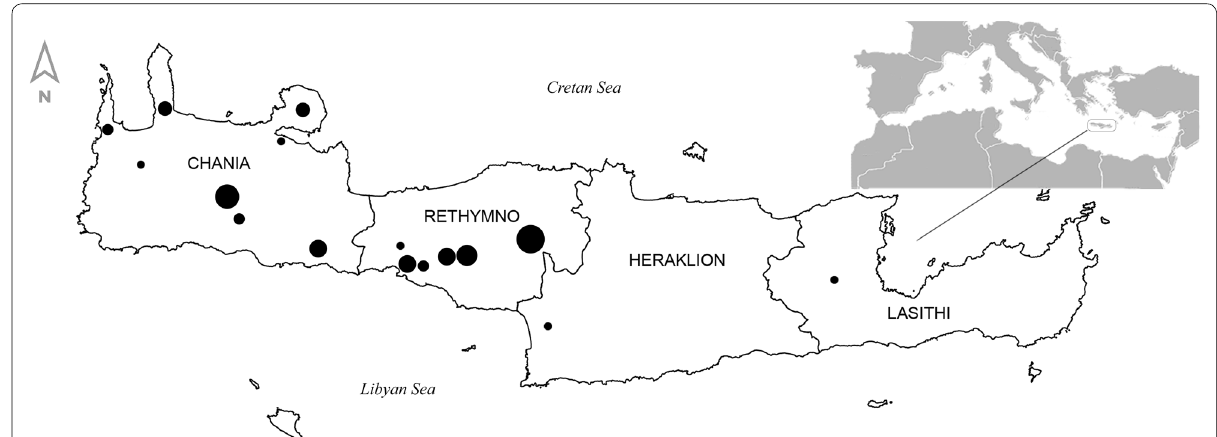
Fig. 3 Areas visited in Crete, Greece, during botanical tours. The size of bullets is proportional to the number of endemic taxa (species and subspecies) advertised to be seen in each area; lowest value Heraklion, Lasithi), in which the island is administratively divided and the position of Crete in the Mediterranean (inset)